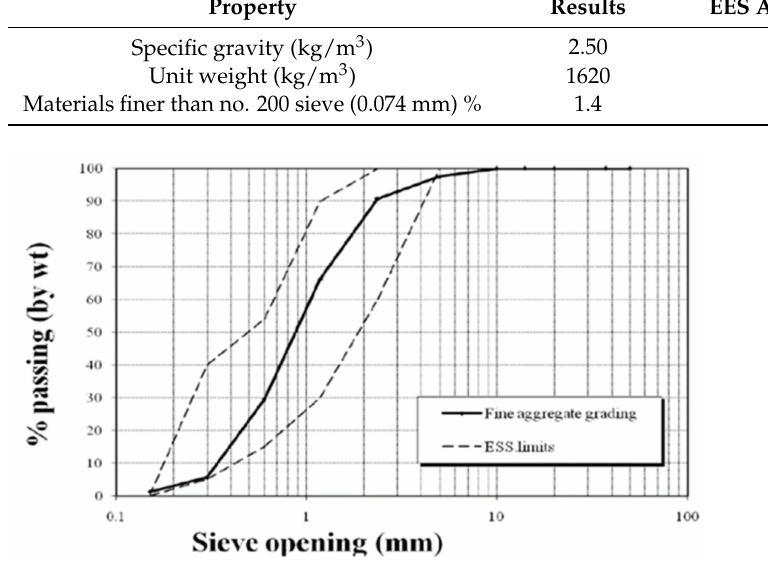
Figure 2. Grading curve for the fine aggregate.